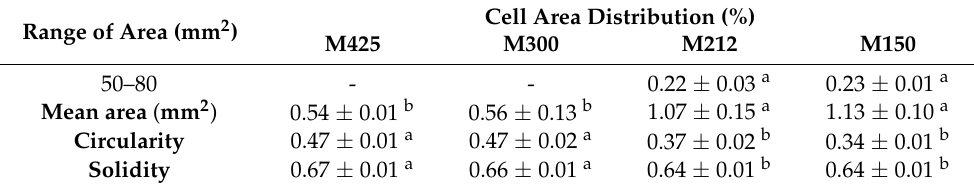
M425, grape pomace powder at 600–425 µ m; M300, grape pomace powder at 425–300 µ m; M212, grape pomace powder at 300–212 µ m; M150, grape pomace powder at 212–150 µ m. Data are represented as means ± SD of three replicates. Different letters in the same row mean a significant difference at p < 0.05.